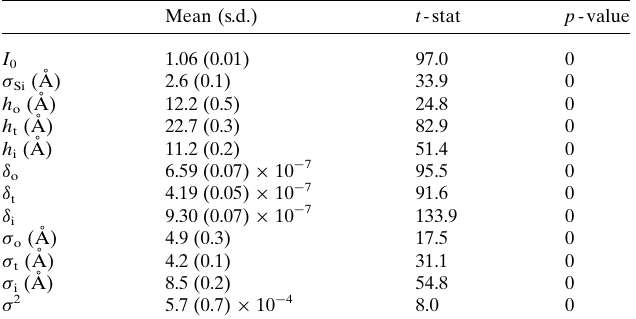
Table 2 X-ray reflectivity results.